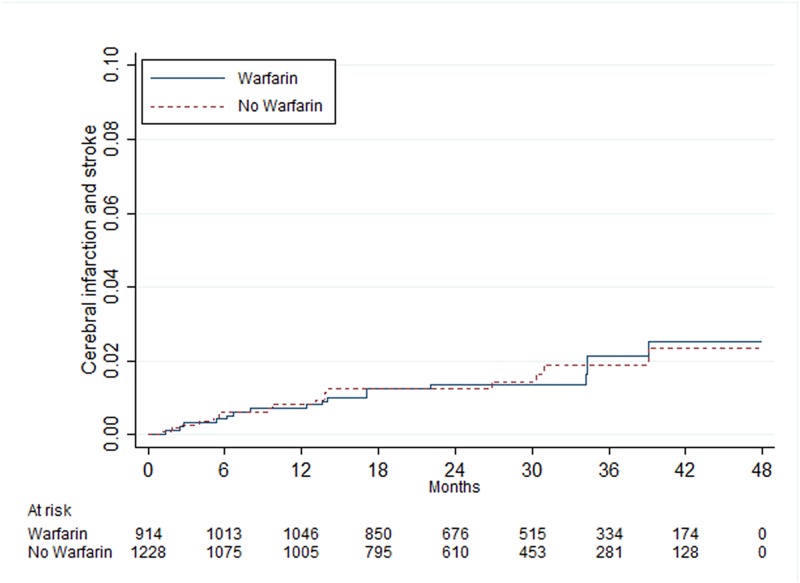
Risk of cerebral infarction and stroke in men <65 years of age with atrial fibrillation and one additional point from the CHA2DS2-VASc score other than sex or agea.aOne additional point indicates congestive heart failure, hypertension, diabetes mellitus or vascular disease.